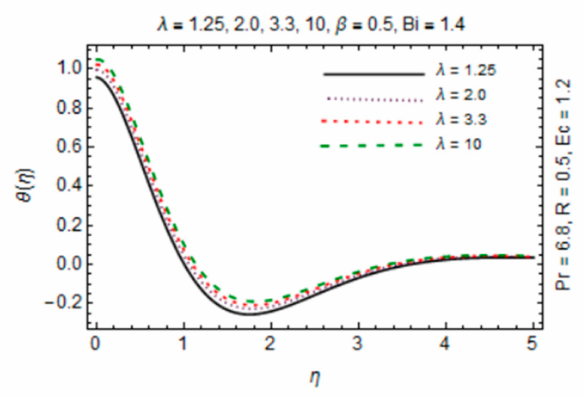
Figure 12. λ verses temperature